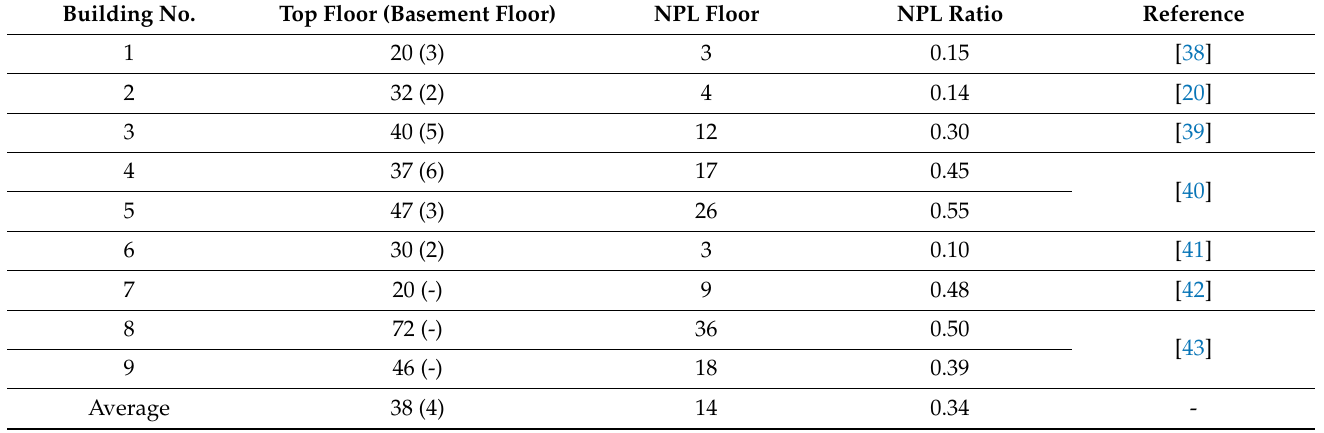
Table A1. Neutral pressure level (NPL) investigated in Korea [29].